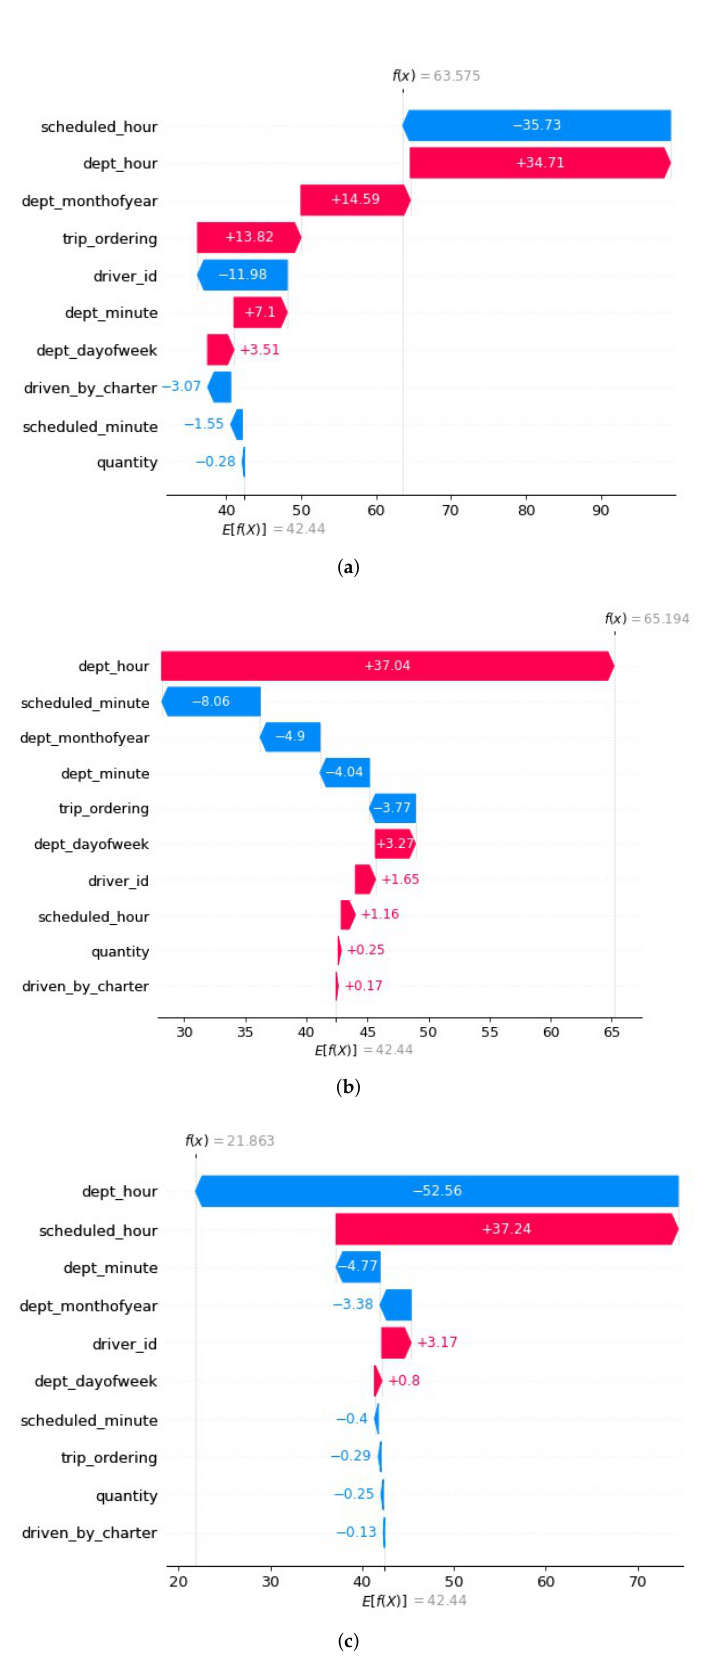
Figure 6. SHAP Waterfall Plots for Explaining Three Prediction Instances. ( a ) Instance-1. ( b ) Instance-2. ( c )